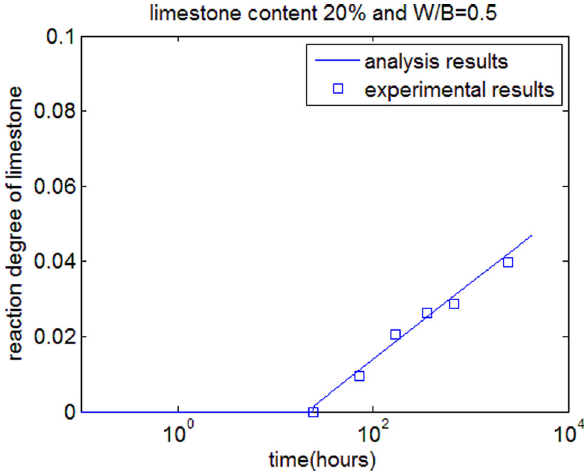
Fig. 1 Reaction degree of